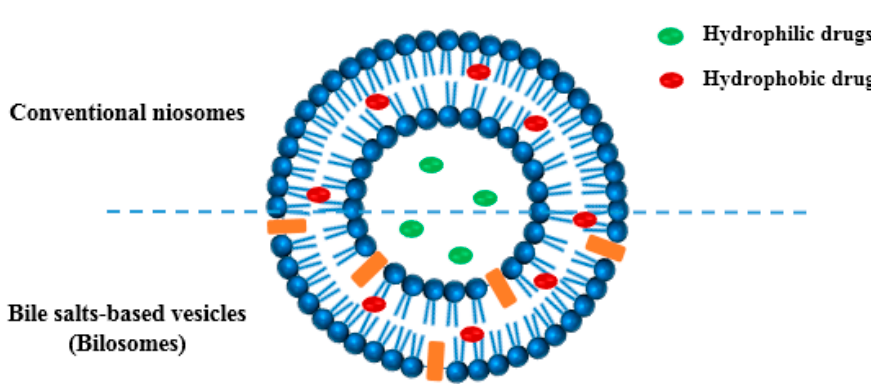
Figure 1. Schematic representation of conventional niosomes and bilosomes as vesicular carriers for both hydrophilic and hydrophobic drugs.